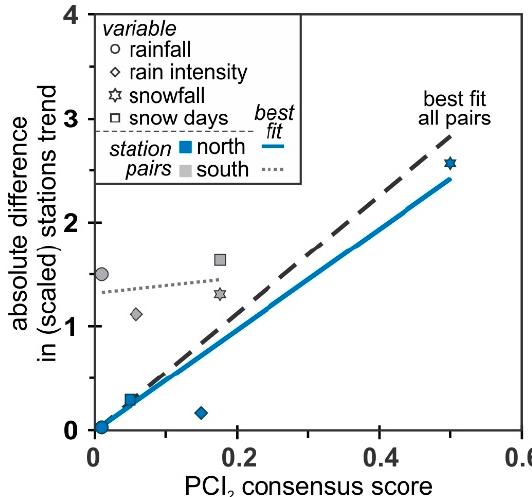
Figure 5. Comparison of the absolute differences between stations within an aimag versus the herder PCI 2 consensus score. The linear best fit for the Northern (solid blue) and all station pairs (dashed black) was fit through the origin, but the Southern (dotted grey) line was not.